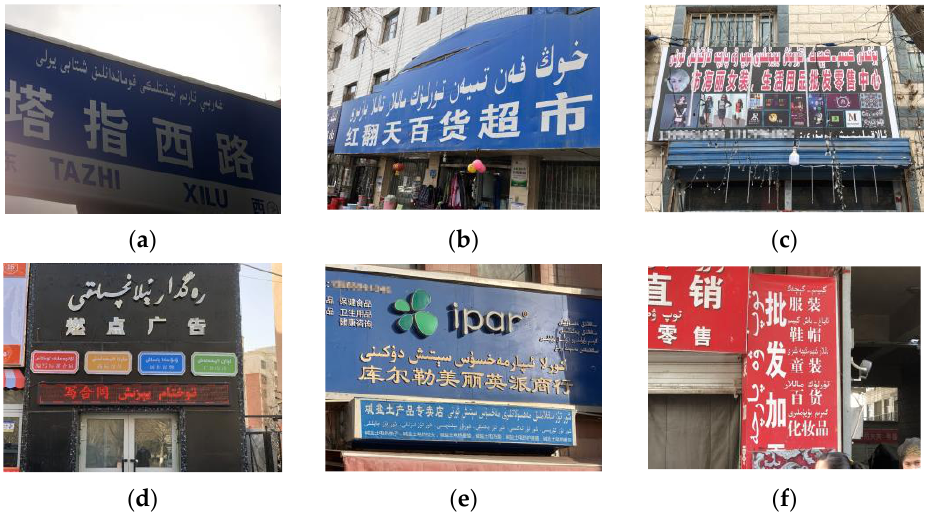
Figure 1. Difficult detection text sample. ( a ) Scene image with uneven illumination; ( b ) perspective text in scene image; ( c ) scene image with partial text obscured; ( d ) artistic text in scene image; ( e ) multiscale text in scene images; and ( f ) multidirectional text in scene images. (Text description in the figure: ( a ) Tazhi West Road; ( b ) Hongfantian department store; ( c ) Buhaili women’s clothing, daily necessities wholesale and retail center; ( d ) Burning advertisement; ( e ) korla ipar store, which sells alkaline salt products; ( f ) This is a store that wholesales or retails clothing, cosmetics, etc.)